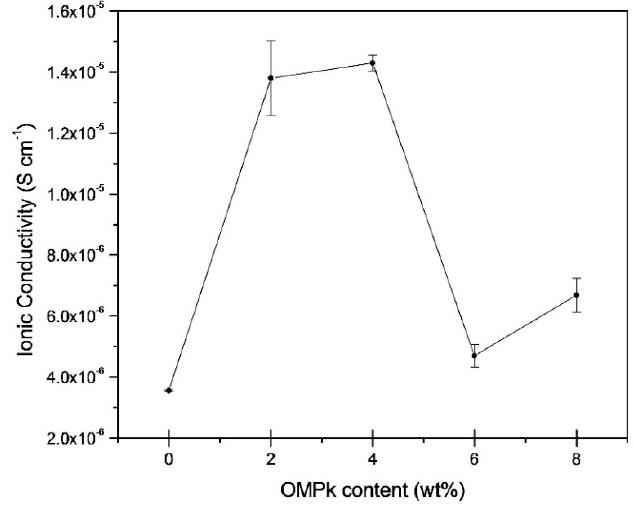
Figure 10. Graph of the ionic conductivity of the solid polymer electrolyte (SPE) with respect to the O -methylene phosphonic κ -carrageenan (OMPk) content in N -methylene phosphonic chitosan (NMPC).